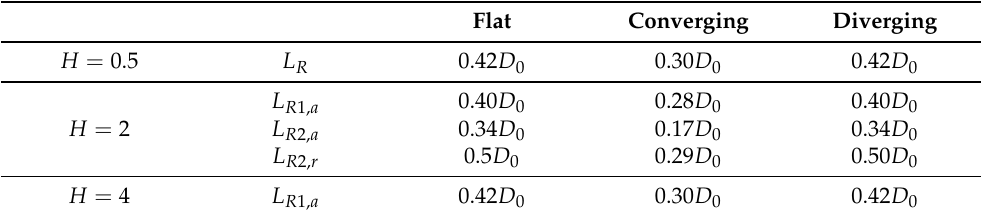
Table 3. Size of the